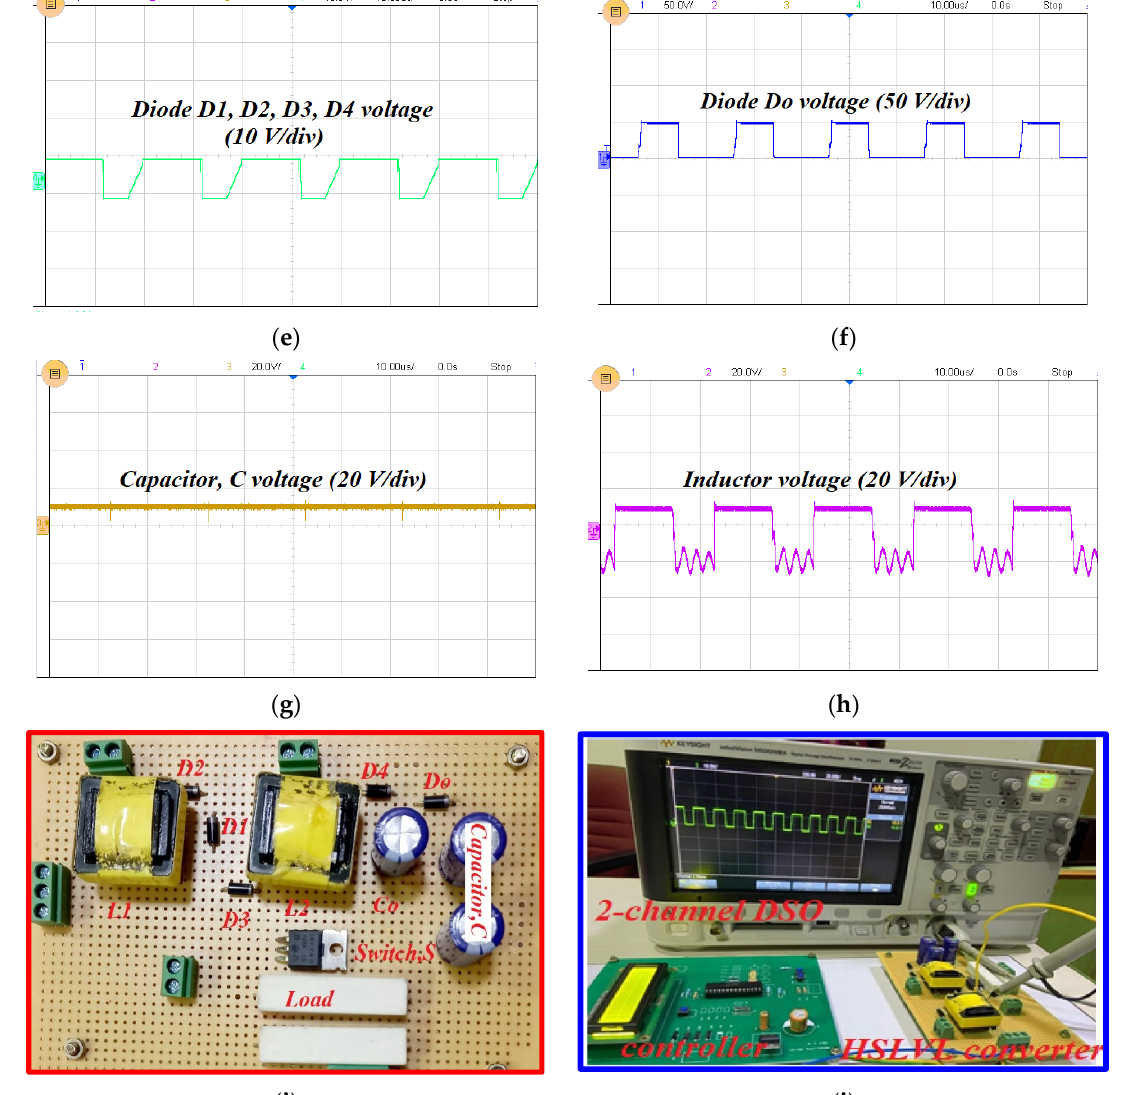
Figure 14. Test results. ( a ) Input voltage, ( b ) Output voltage, ( c ) Gate pulse, ( d ) Switch voltage stress, ( e ) Diode (D 1 –D 4 ) voltage, ( f ) Output diode Do voltage, ( g ) Capacitor C voltage, ( h ) Inductor voltage (100 µs/div), ( i ) Photograph of the HSIVL converter tested, and ( j ) Entire setup implemented for validation.